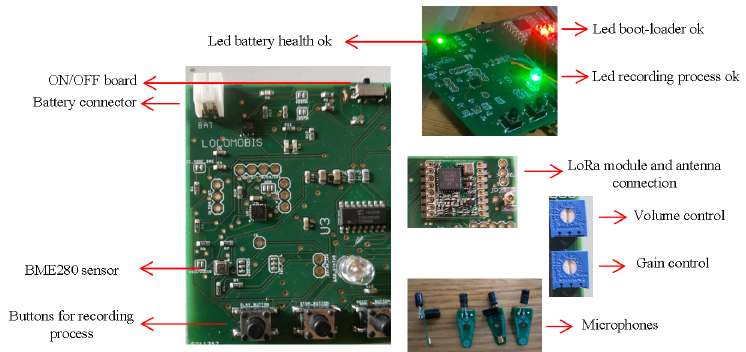
Figure 15. Prototype and principal test